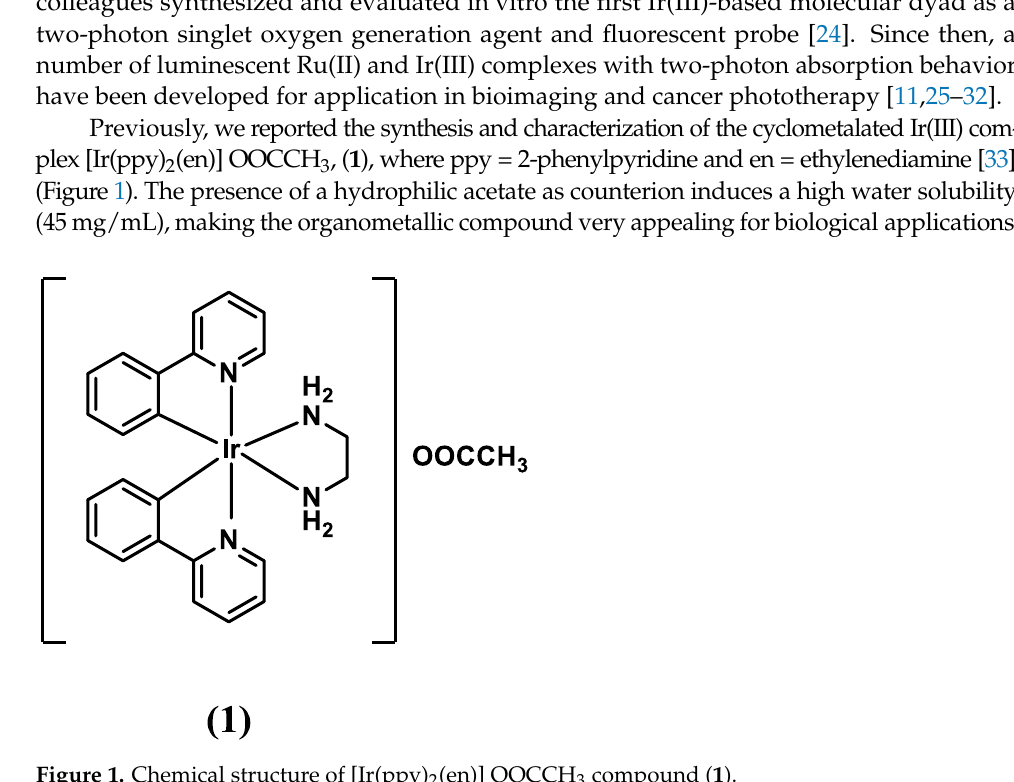
Figure 1. Chemical structure of [Ir(ppy) 2 (en)] OOCCH 3 compound ( 1 ).